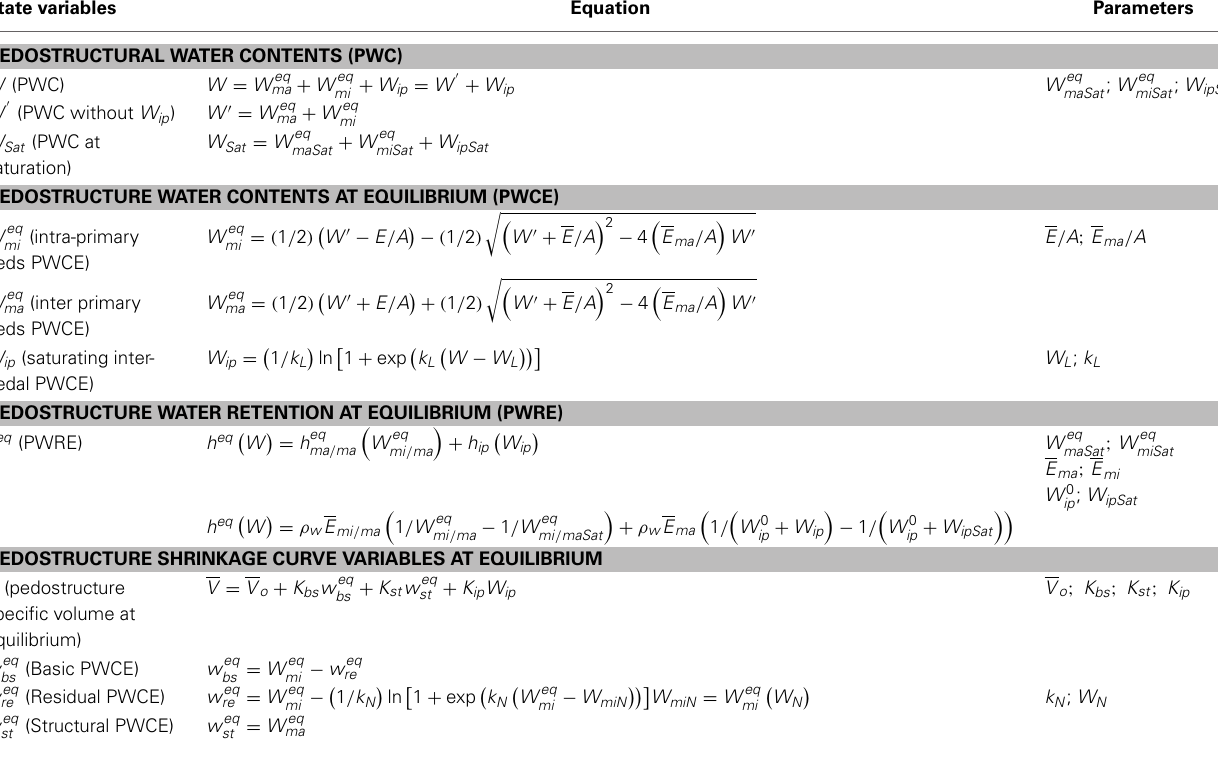
Table 2 | The state variables, equations, and parameters of the Pedostructure soil moisture characteristic curves. State variables Equation